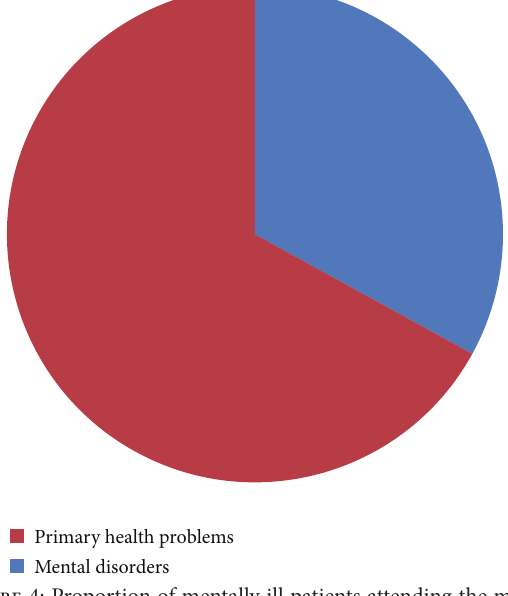
Figure 3: Relative utilization of health facilities over the last decade.